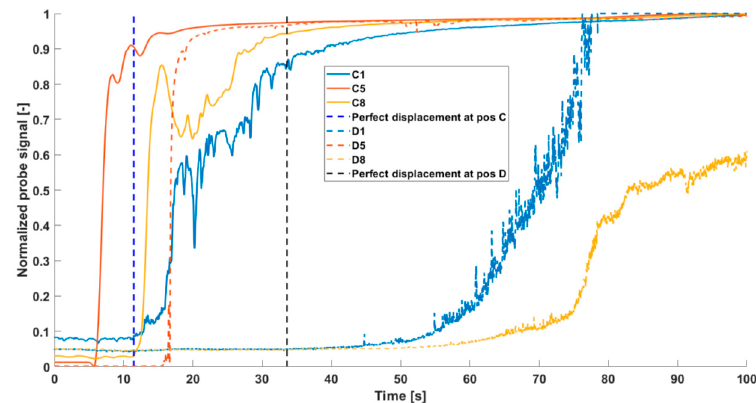
Figure 19. Measurement of displacing fluid fraction immediately upstream and downstream of the washout section for an experiment in horizontal wellbore with concentric inner pipe. Probes C1/D1 and C8/D8 measure fluid fraction near top upstream/downstream of washout section, while probes C5/D5 measure corresponding fluid fractions near the bottom.